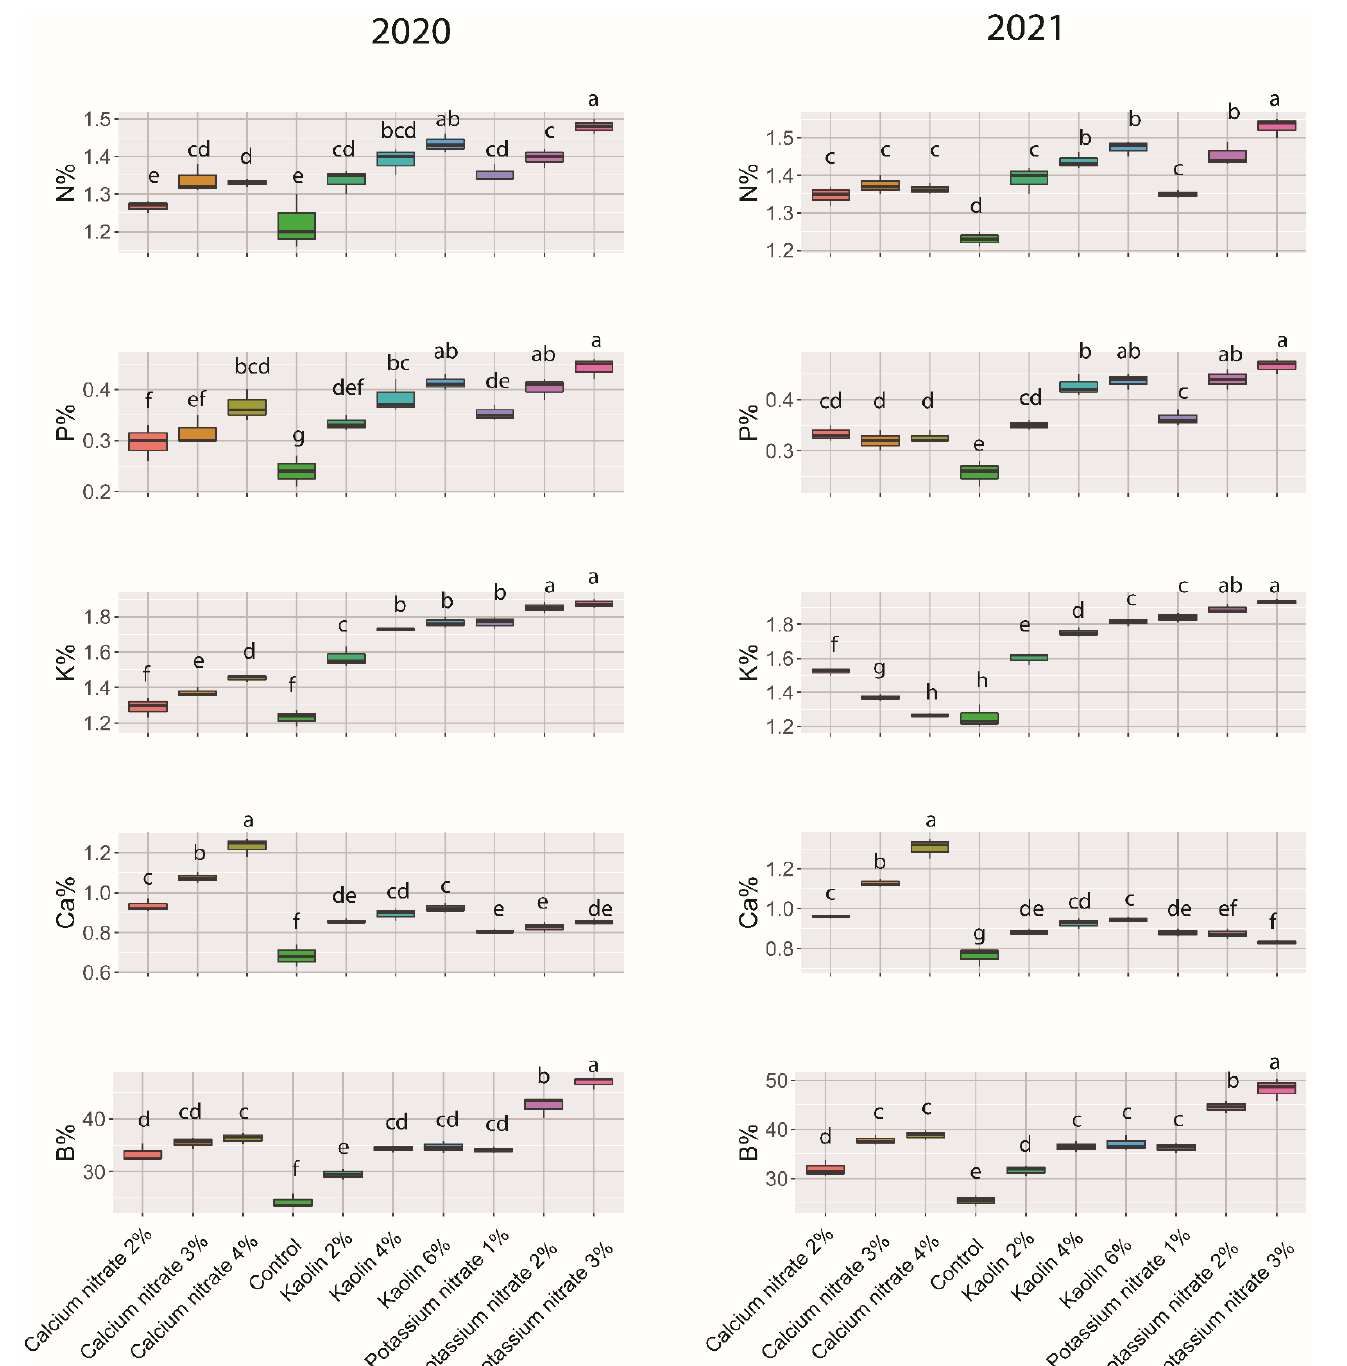
Figure 2. The effect of the foliar application of potassium nitrate, calcium nitrate and kaolin on the fruit content from nitrogen, phosphorous, potassium, calcium and boron of ‘Wonderful’ pomegranates during the 2020 and 2021 seasons. The same letters make clear that there is no significant difference among treatments in the same column. Data are mean values of 10 replicates (10 trees).